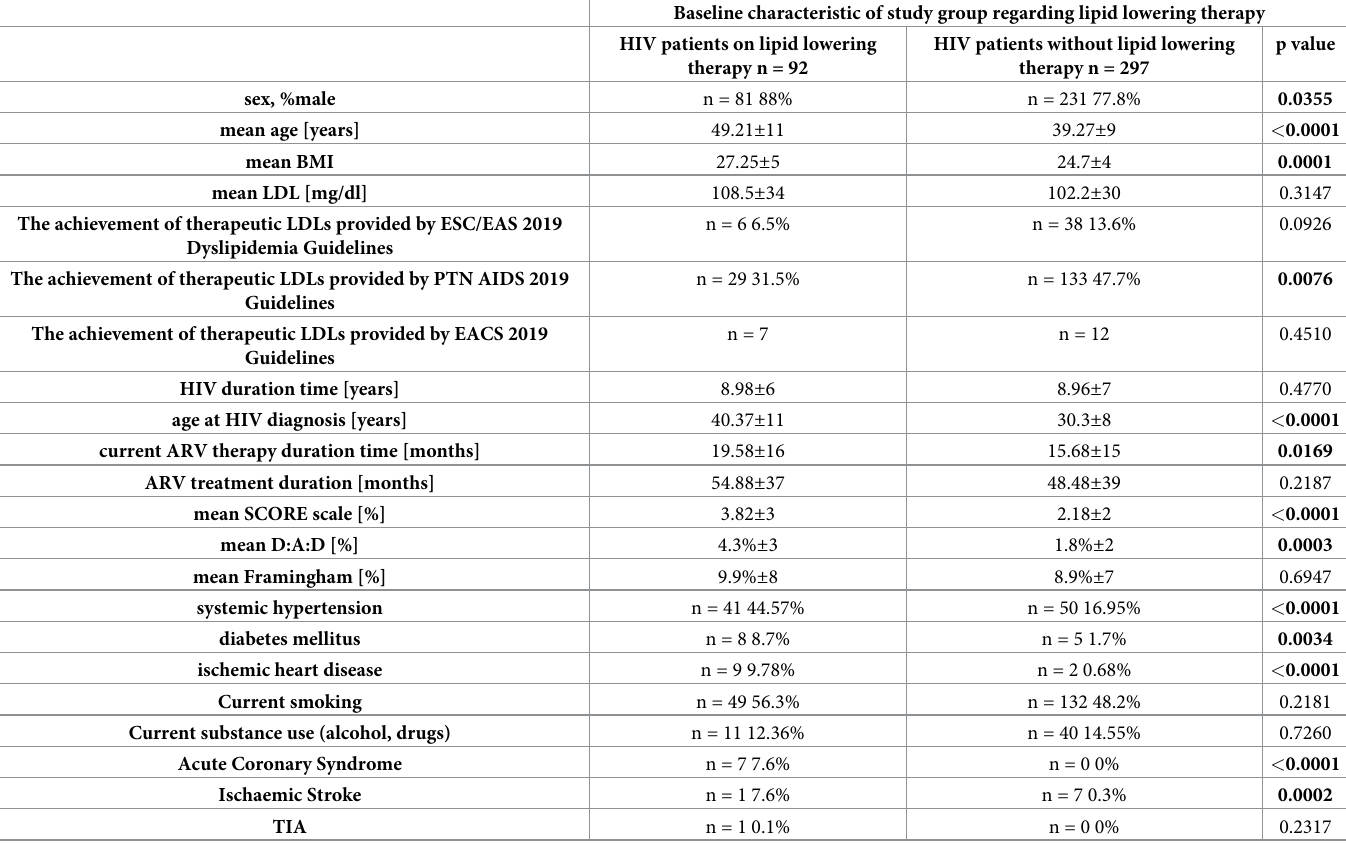
Table 1. Baseline characteristic of study group regarding lipid lowering